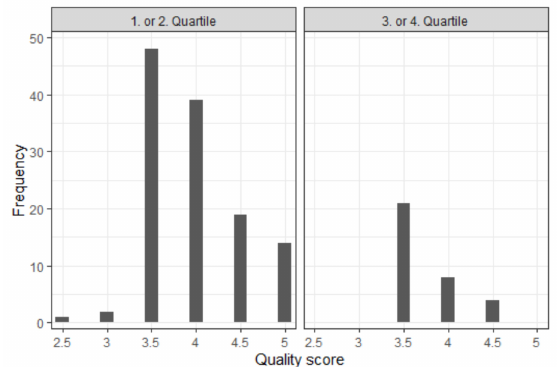
Figure 3. Paper quality score and journal quartile ranking